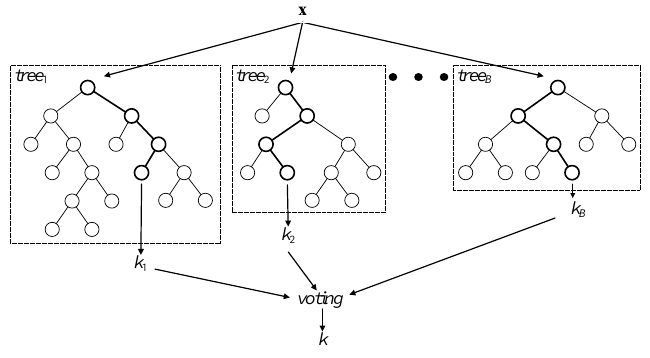
Figure 2. A general architecture of a random